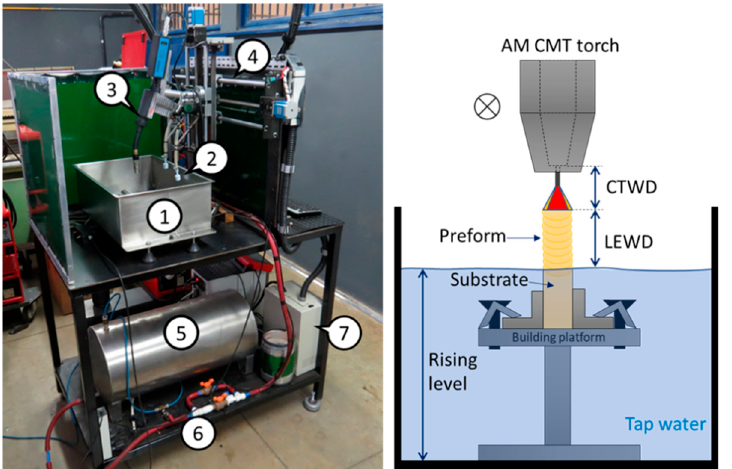
Figure 1. Experimental rig developed by da Silva [14] and cross-sectional schematic representation of the deposition region: ( 1 ) NIAC work tank, ( 2 ) NIAC water level control, ( 3 ) AM CMT torch, ( 4 ) AM motion system on the gantry, ( 5 ) NIAC pressurized water tank, ( 6 ) NIAC hydraulic and pneumatic control, and ( 7 ) AM CNC